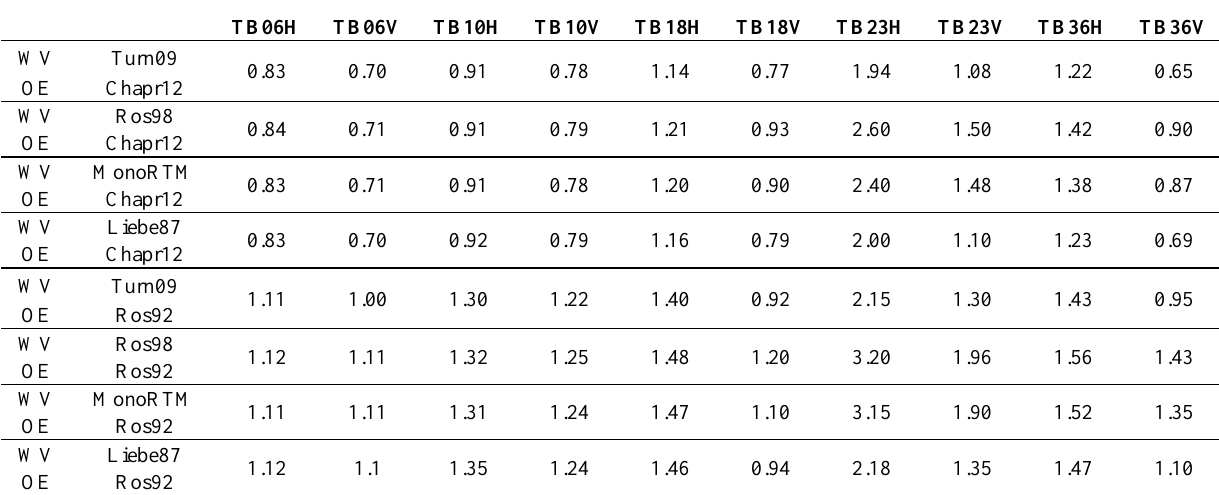
Table 3. Root mean square difference (in K) between simulations and measurements for 8 model combinations for AMSR-E lower frequency channels. Liebe87 is used for oxygen